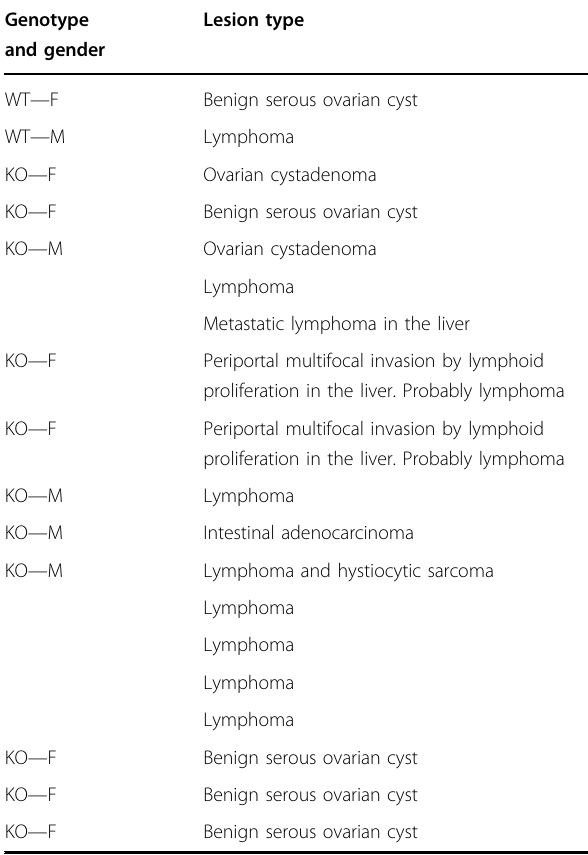
Table 1 Macroscopic lesions observed in 20-month- old